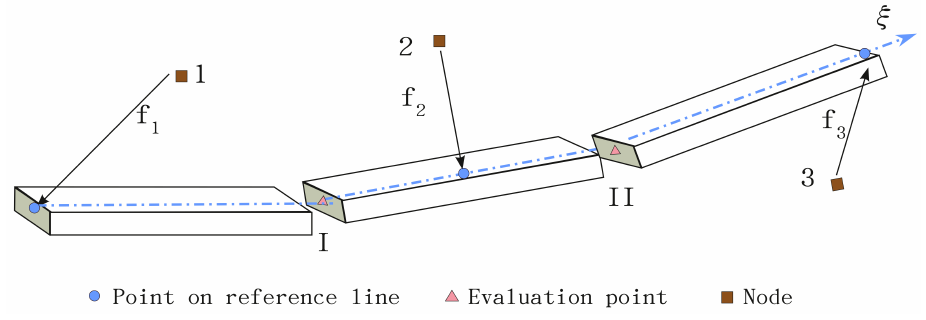
Figure 6. Three-node finite volume